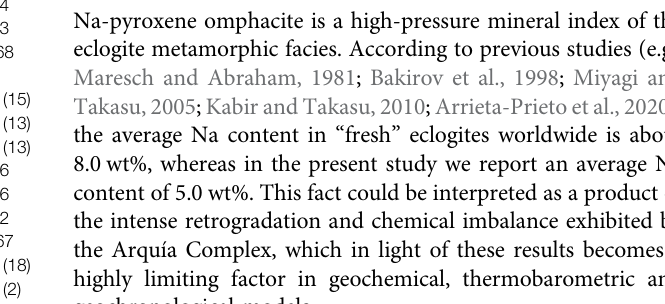
TABLE6| Bonddistances,polyhedralvolumes,quadraticelongation(TQE),bond angle variance (BAV) and other geometrical parameters for omphacite.